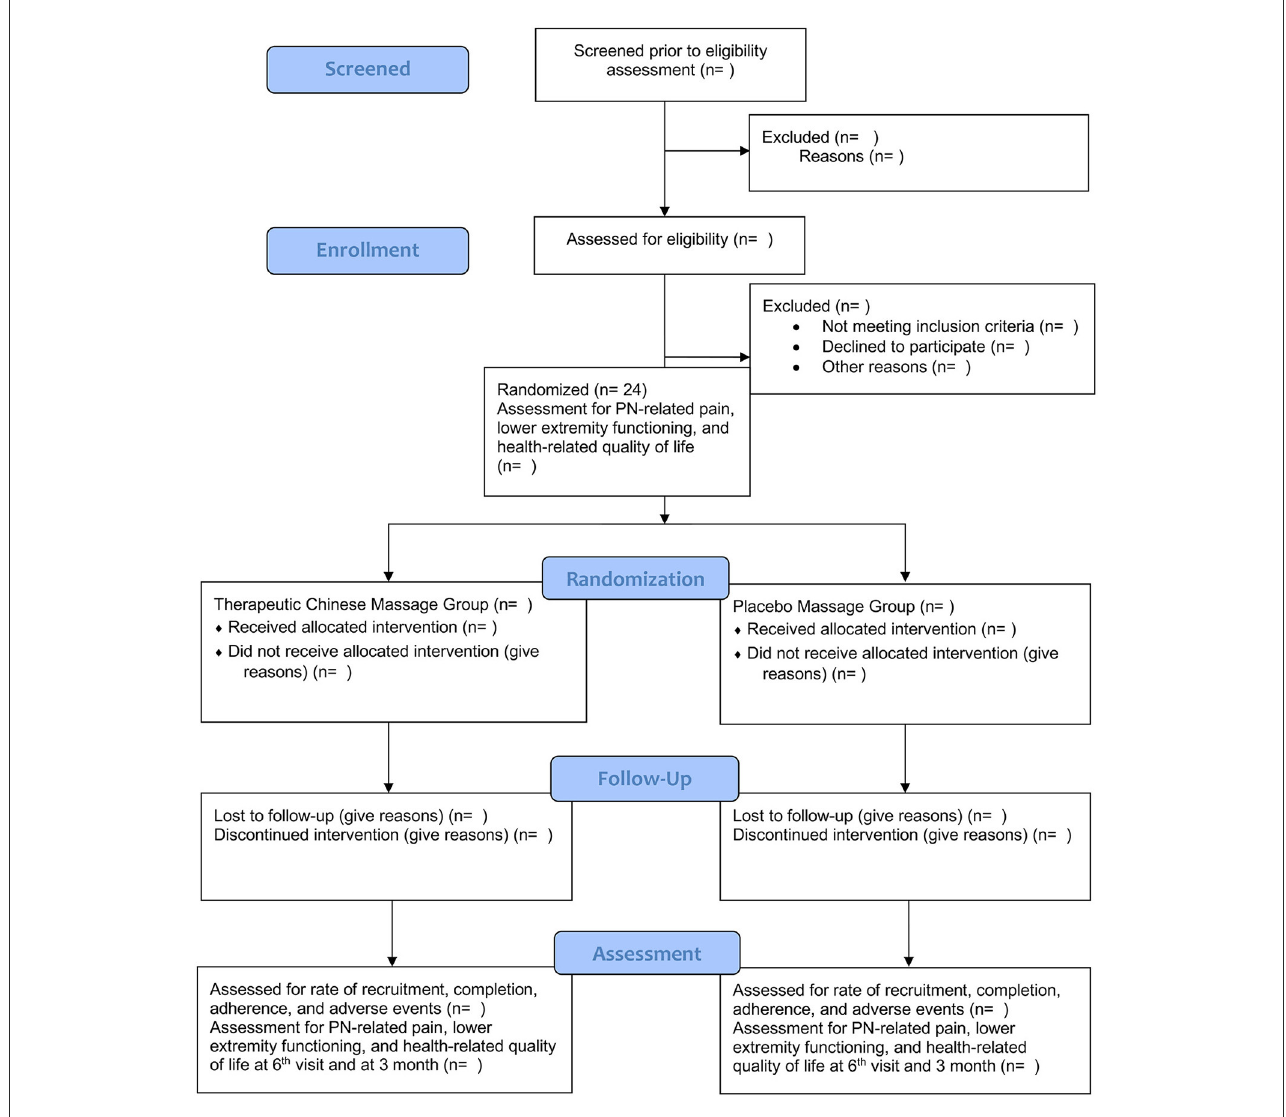
FIGURE1 The flow chart of the